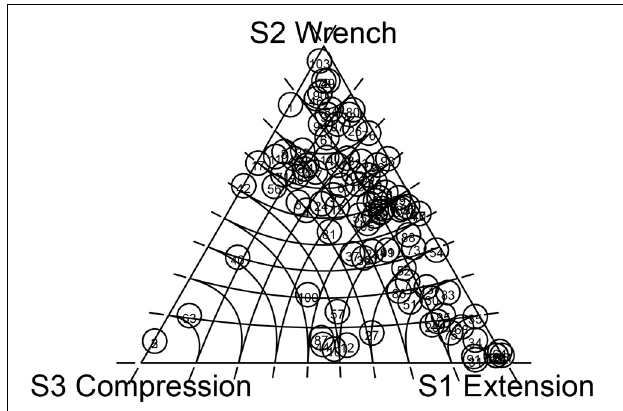
FIGURE 14 | Distribution of the P, B, and T-axes for the 104 focal mechanisms of the cell 15–16 (corresponding to the stress tensor solution number 48, see Table